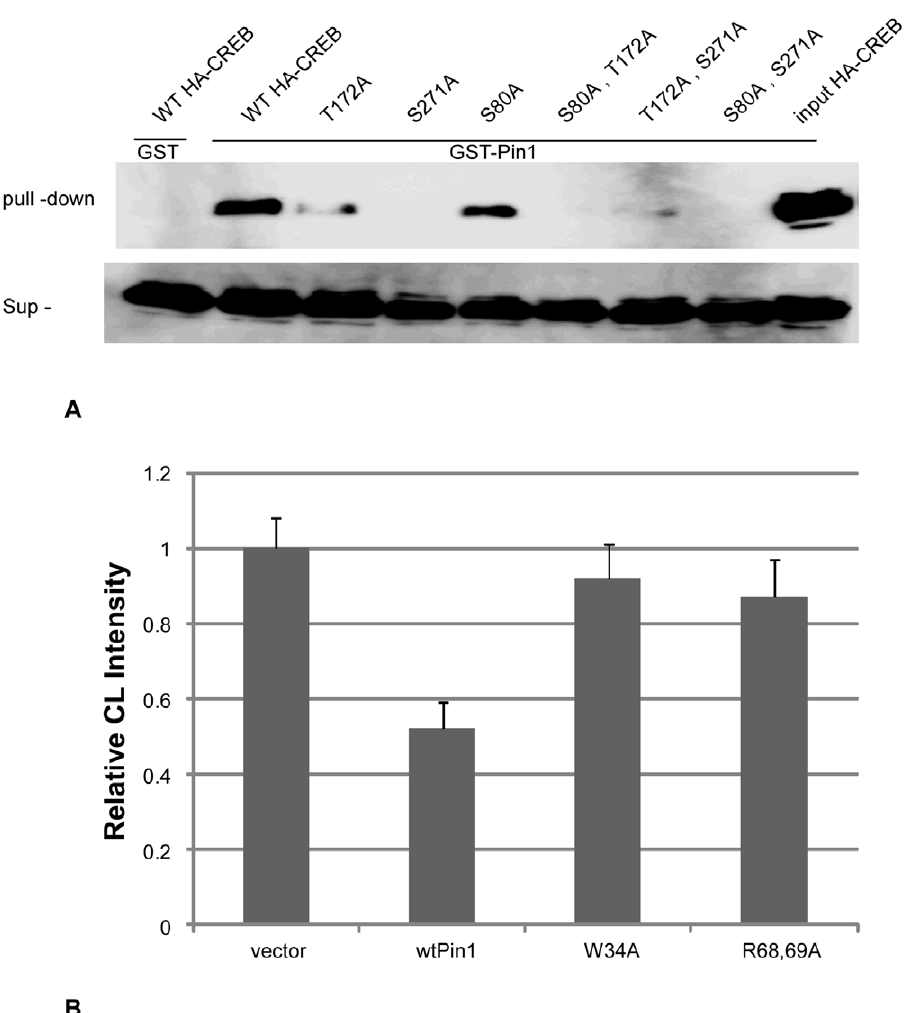
Figure 5. Association of Pin1 and CREB. (A) Lysates of COS-7 cells, transfected with HA-CREB ( wild-type; T172A; S271A; S80A; S80A/T172A; T172A/ S271A; S80A/S271A ) and stimulated with 10 m M forskolin for 6 hr, were pulled down with GST-Sepharose (control), GST-Pin1-Sepharose, and input (upper panel). CREB levels in the supernatant are shown in the lower panel. (B) 10 6 of COS-7 were co-transfected with pCRE-Luc and CMV-Pin1 (wt; wild type, W34A; mutation at WW domain, R68,69A; prolyl isomerase mutant). The cells were treated with 100 m M of forskolin (CST) for 6 hours and luciferase activities were determined using the Dual-Luciferase Reporter Assay System (Promega).